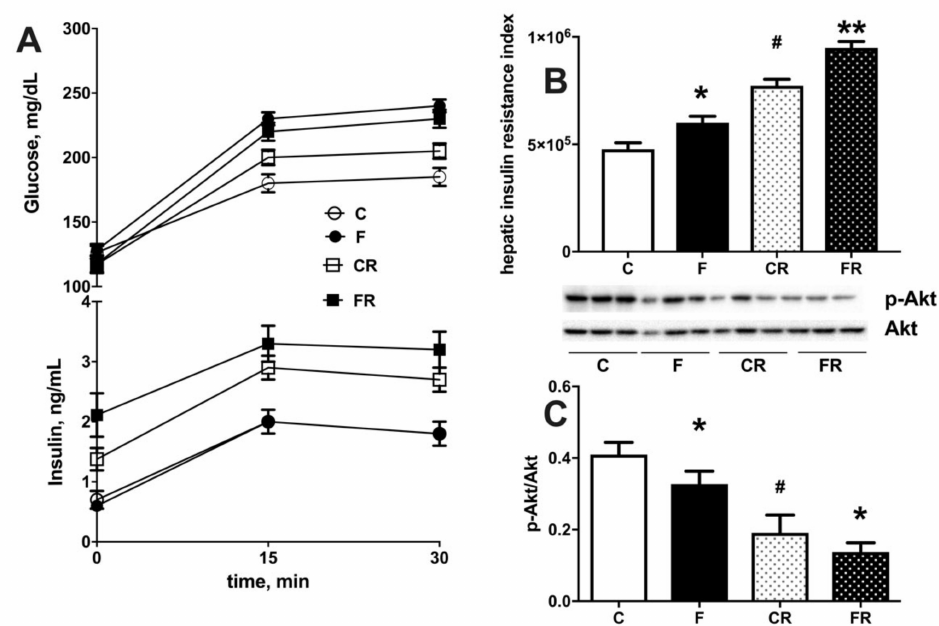
Figure 7. Plasma glucose and insulin during 30 min after intraperitoneal injection of glucose ( A ), hepatic insulin resistance index ( B ) and degree of phosphorylation of kinase Akt (with representative western blot) ( C ) in liver from control (C), fructose (F), control rescue (CR) and fructose rescue (FR) rats. Values are the means ± SEM of eight different rats. * p < 0.05, ** p < 0.01 compared to respective control; # p < 0.05 compared to C rats (one-way ANOVA followed by Tukey post-test).